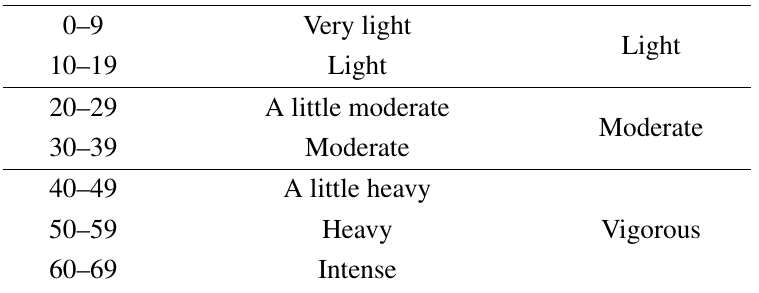
Table 3. Effort levels from relative cardiac cost